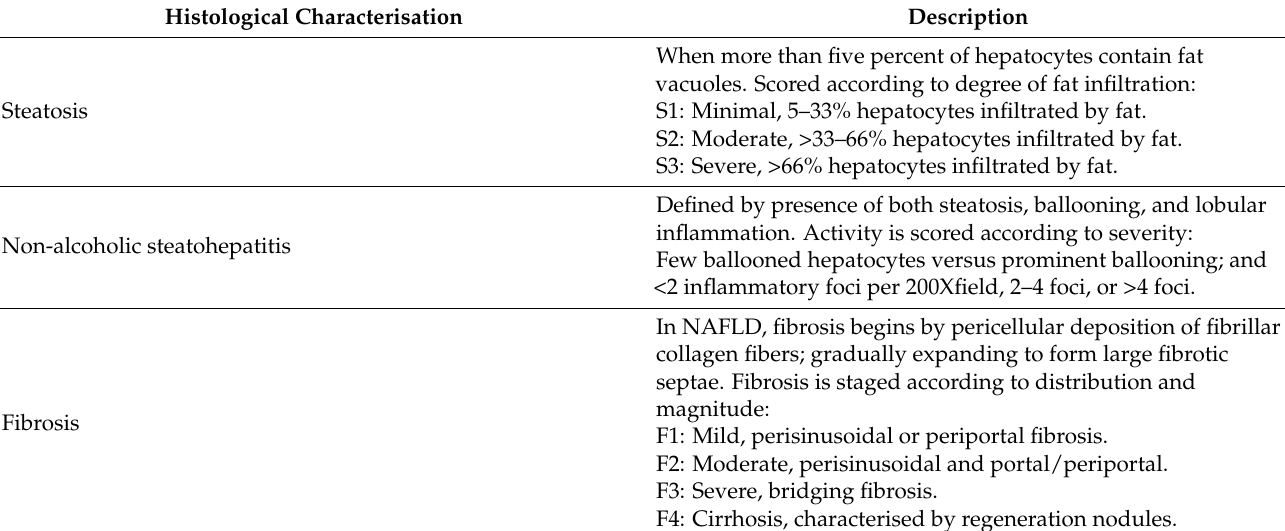
Table 1. Histological staging and grading of non-alcoholic fatty liver disease 1 . Histological Characterisation Description When more than five percent of hepatocytes contain